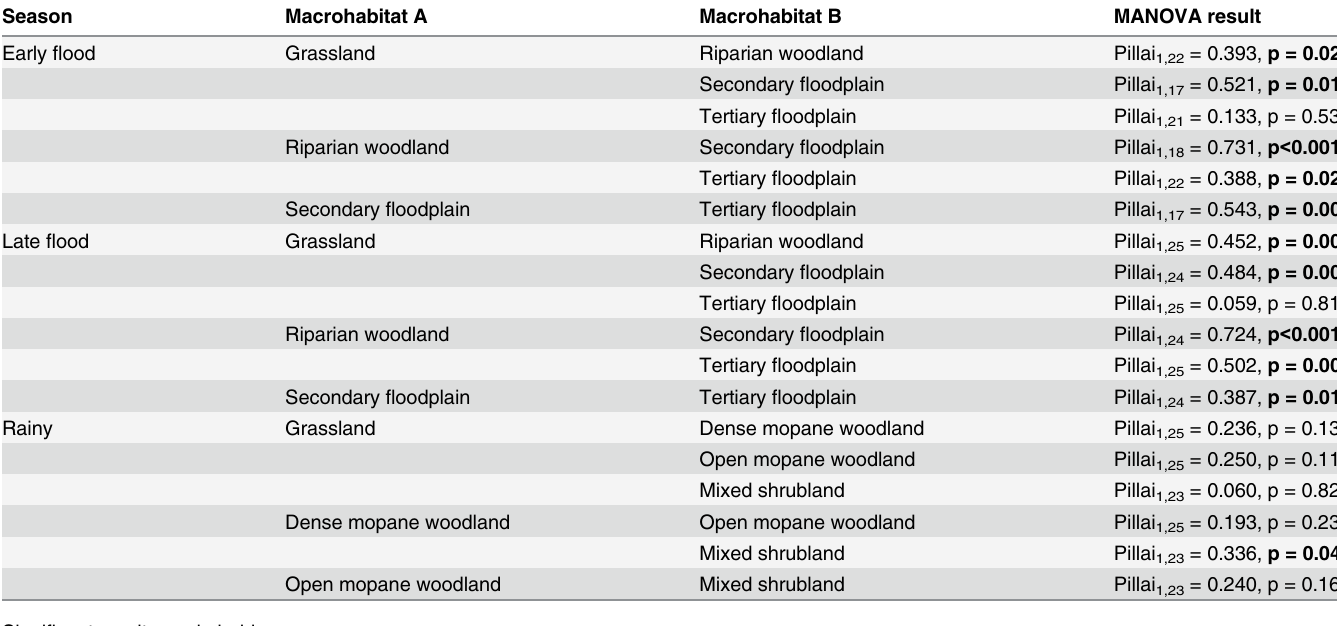
Table 3. MANOVA results from comparisons of proportional behaviour in seasonally-preferred macrohabitats.